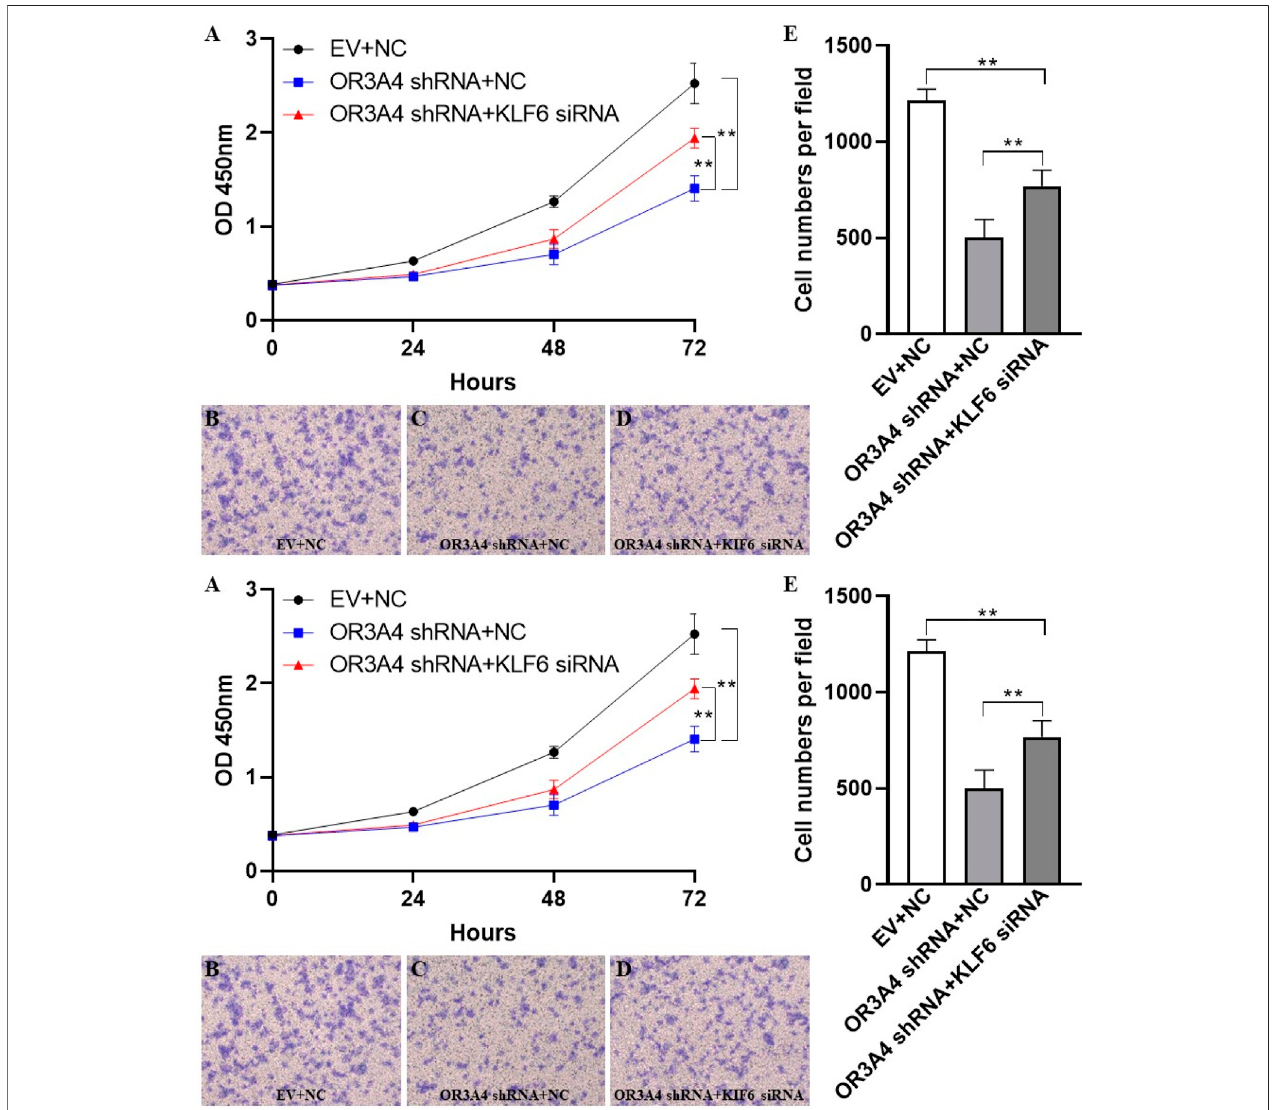
FIGURE3| KLF6mediatedtheproliferationandmigrationoflncRNAOR3A4inSKOV3 (A) KnockingoutofOR3A4andthedownregulationofKLF6expressioncan rescuetheproliferationofSKOV3cells (B,E) KnockedoutOR3A4whiledownregulatedKLF6savedthemigrationlevelofSKOV3cells (B – D) Typicalpicturesoftranswell